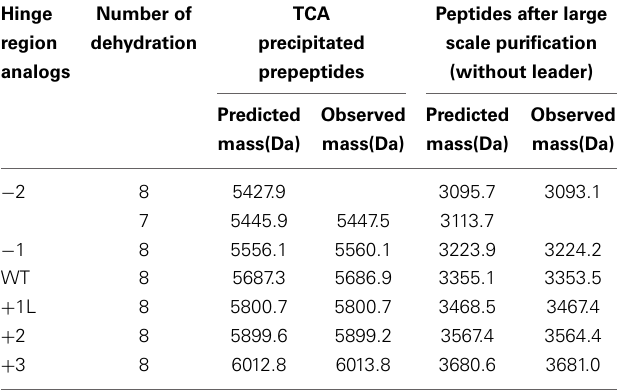
Table 3 | Molecular mass of hinge region analogs detected by